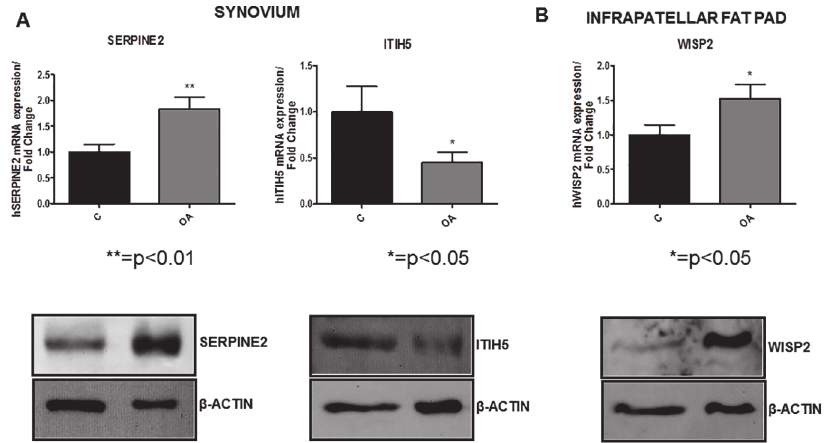
Fig 2. Determination of SERPINE2, WISP2 and ITIH5 mRNA and protein expression by quantitative real-time PCR and western blot. A. PCR results were shown in fold change, where black bars represent the mRNA expression of SERPINE2 and ITIH5 in 10 different synovial tissues obtained from healthy donors. Grey bars represent the mRNA expression of SERPINE2 and ITIH5 in 30 different synovial tissues obtained from OA patients. B. PCR results were shown in fold change, where black bars represent the mRNA expression of WISP2 in IPFP obtained from 10 healthy donors. Grey bars represent the mRNA expression of WISP2 in IPFP obtained from 30 OA patients. Statistical analysis was performed using unpaired t -test. P value * = p < 0.05; ** = p < 0.01 C vs OA.